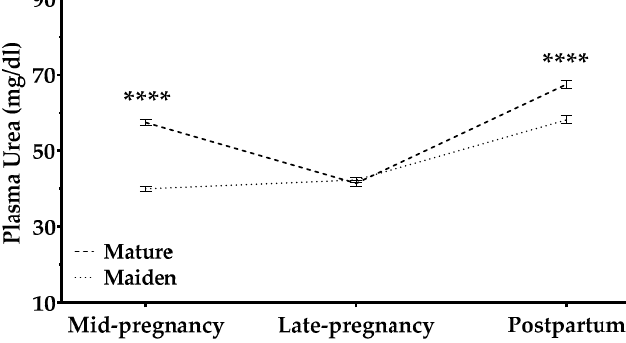
Figure 8. Plasma urea concentrations (mg/dL) in mature ewes (dashed line) and maiden sheep (dotted lines) throughout the study period. Data are mean ± S.E.M. The time × age-group interaction was significant ( p < 0.0001). Asterisks indicate significant differences between age groups at each time point (**** p < 0.0001).